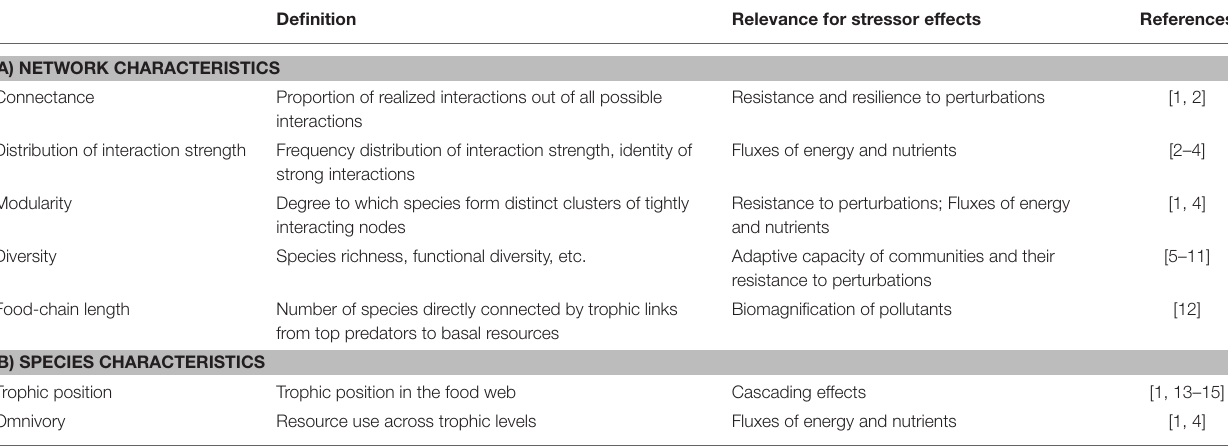
FIGURE 1 | A simplified representation of biotic interactions in a stream food web based on leaf litter (left-hand pathway) and periphyton (right-hand pathway), and affected by multiple stressors (represented by stressors S1 and S2). Black arrows (a,b) represent trophic interactions with top-down effects on resources, with (b) showing the use of a secondary resource by a consumer with a certain degree of omnivory. The blue arrow (c) represents a trophic interaction with bottom-up effects on the consumer. The orange arrow (d) represents an indirect consequence of trophic interactions, e.g., cascading effects or trait-mediated effects, whereas the green arrow (e) represents non-trophic interactions, e.g., competition/facilitation among species in the same trophic level. Purple arrows represent multiple stressors (S1 and S2) with effects on organism groups (i) and on interactions (ii), e.g., due to changes in foraging activity. The inset shows the complete network of species at the site of which the large scheme is an extract or simplification as shown by the dotted box. Blue nodes (trophic level 1) in the inset represent basal resources including autotroph and heterotroph microorganisms (e.g., fungi), green nodes (trophic level 2) represent invertebrates, and orange (trophic level 3), and red nodes (trophic level 4) represent fish. Trophic interactions in the network are exemplified by continuous lines and non-trophic interactions by the dashed lines. TABLE 1 | Examples of network characteristics (A) , and characteristics of species in networks (B) , and their attributes relevant for stressor effects.